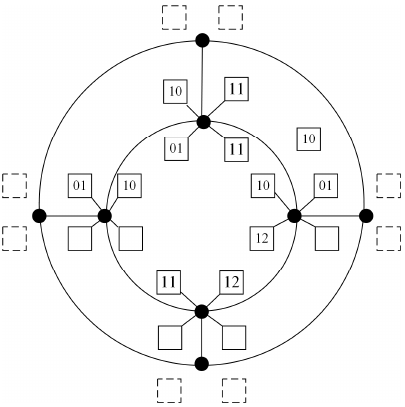
Figure 4. Schematic diagram of double-ring topology.